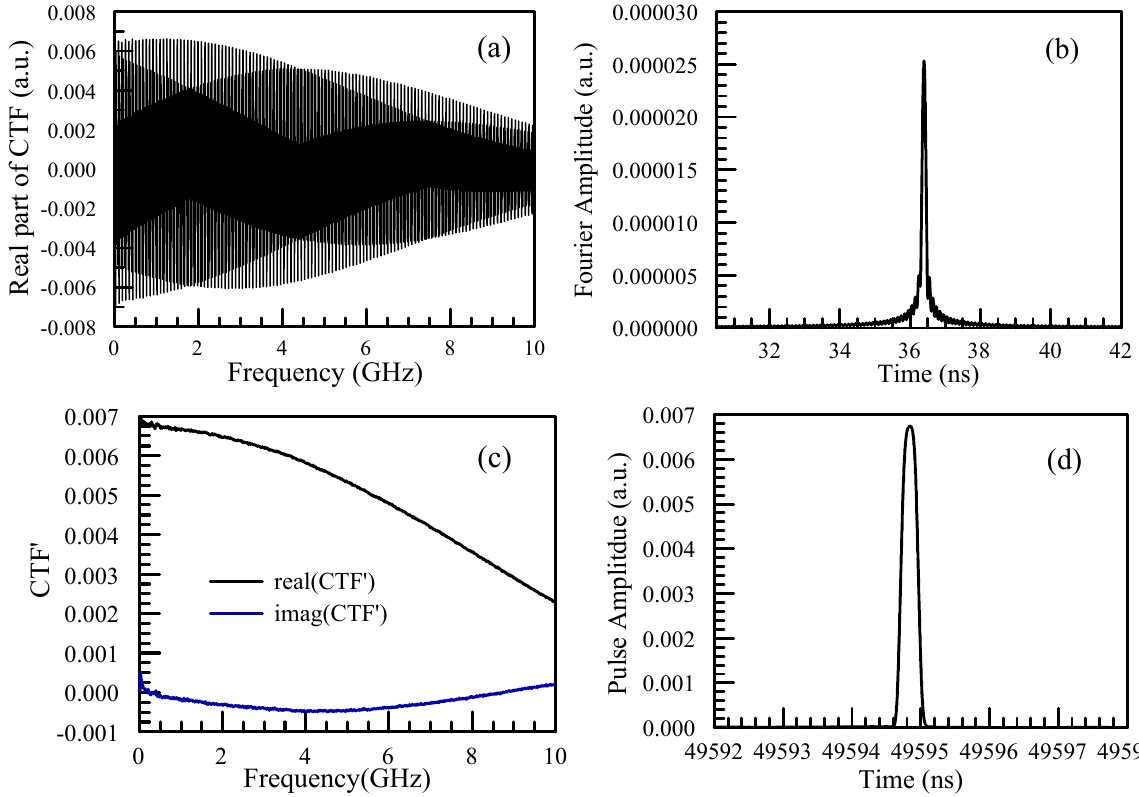
Figure 2. ( a ) The real part of CTF measured by VNA; ( b ) the inverse Fourier transform of the real part of the measured CTF; ( c ) CTF’; ( d ) the calculated output pulse.